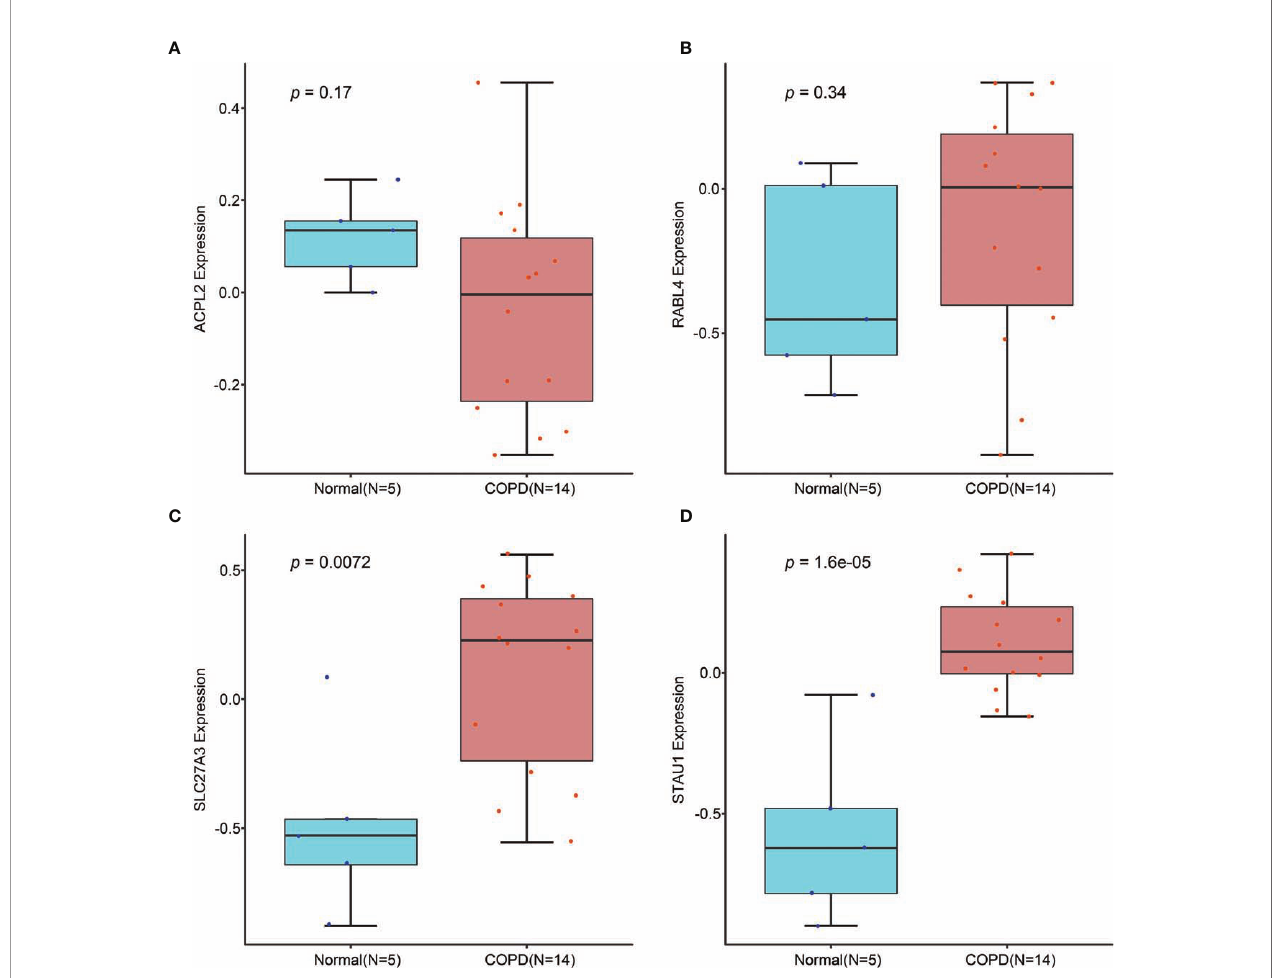
FIGURE 4 | Validation of the expression of candidate diagnostic markers in the GSE106986 dataset. (A) ACPL2; (B) RABL4; (C) SLC27A3; (D)